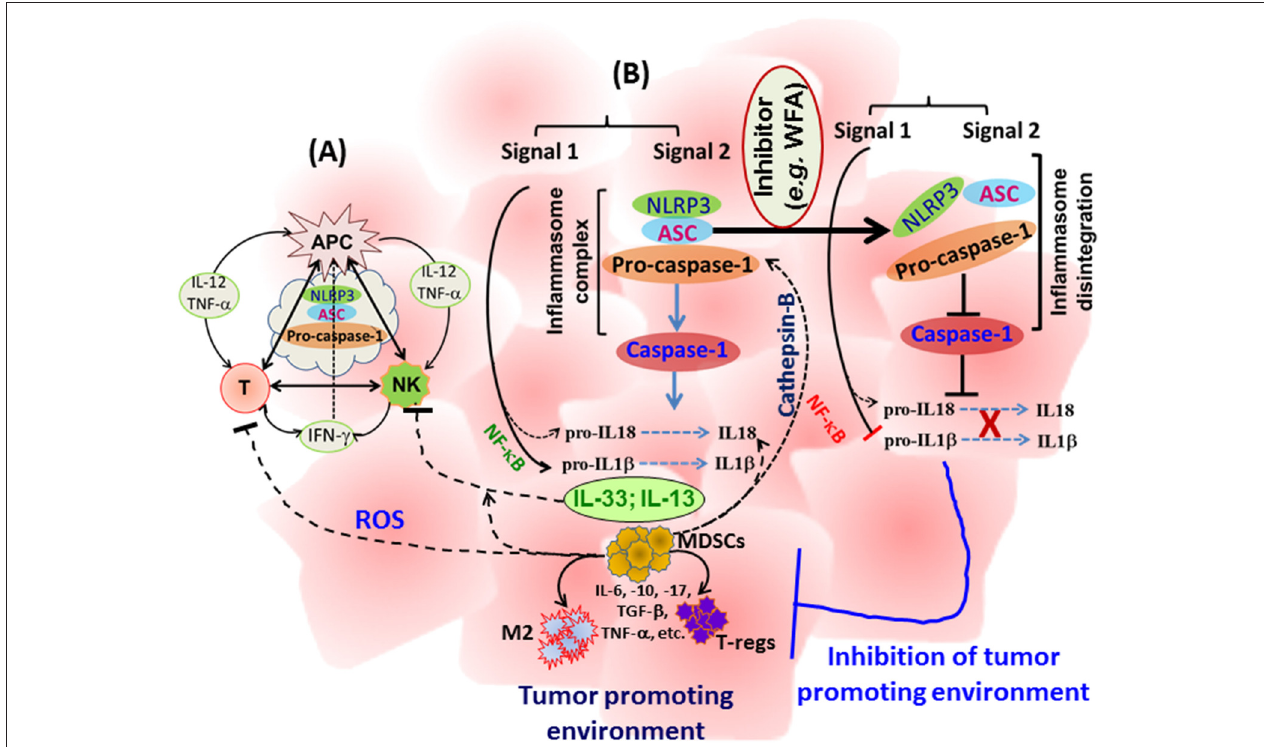
FIGURE 1 | A schematic representation of the cross-talk between APC, NK, and T cells with a potential influence of inflammasome regulating immune cell activity (A) , and a summary of events involved in tumor growth and metastasis and a proposed mechanism to block inflammasome activity (B) . IL-1 β and IL-18 are well-known primary targets; however, multiple cytokines-chemokines could be simultaneously reduced in the tumor microenvironment with subsequent inhibition of immune suppressor cells, providing a space to enhance anti-tumor immunity. WFA: Withaferin-A.